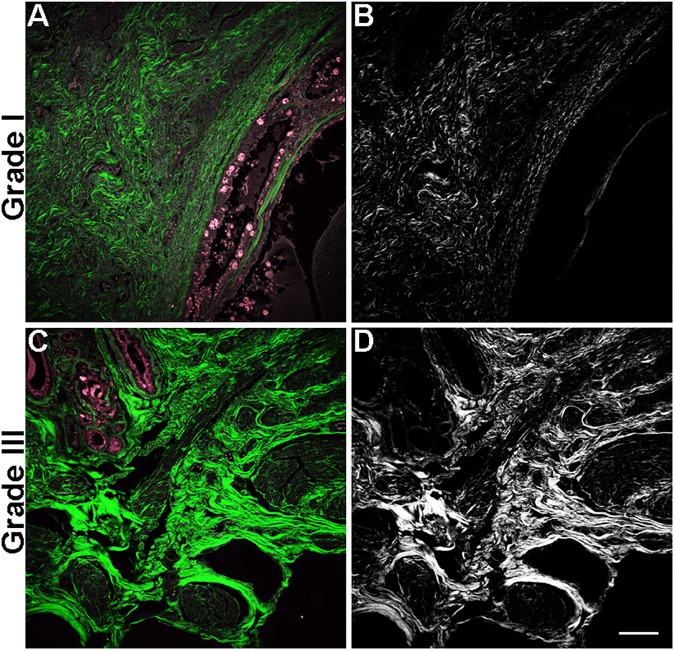
Fibrillar collagen in canine mammary tumors.Representative images of SHG signal (white, B and D; pseudocolored green A and C) and autofluorescence (pink, A and C) in low (grade I, A and B) and high-grade (grade III, C and D) mammary tumors. Scale bar = 50 μm.